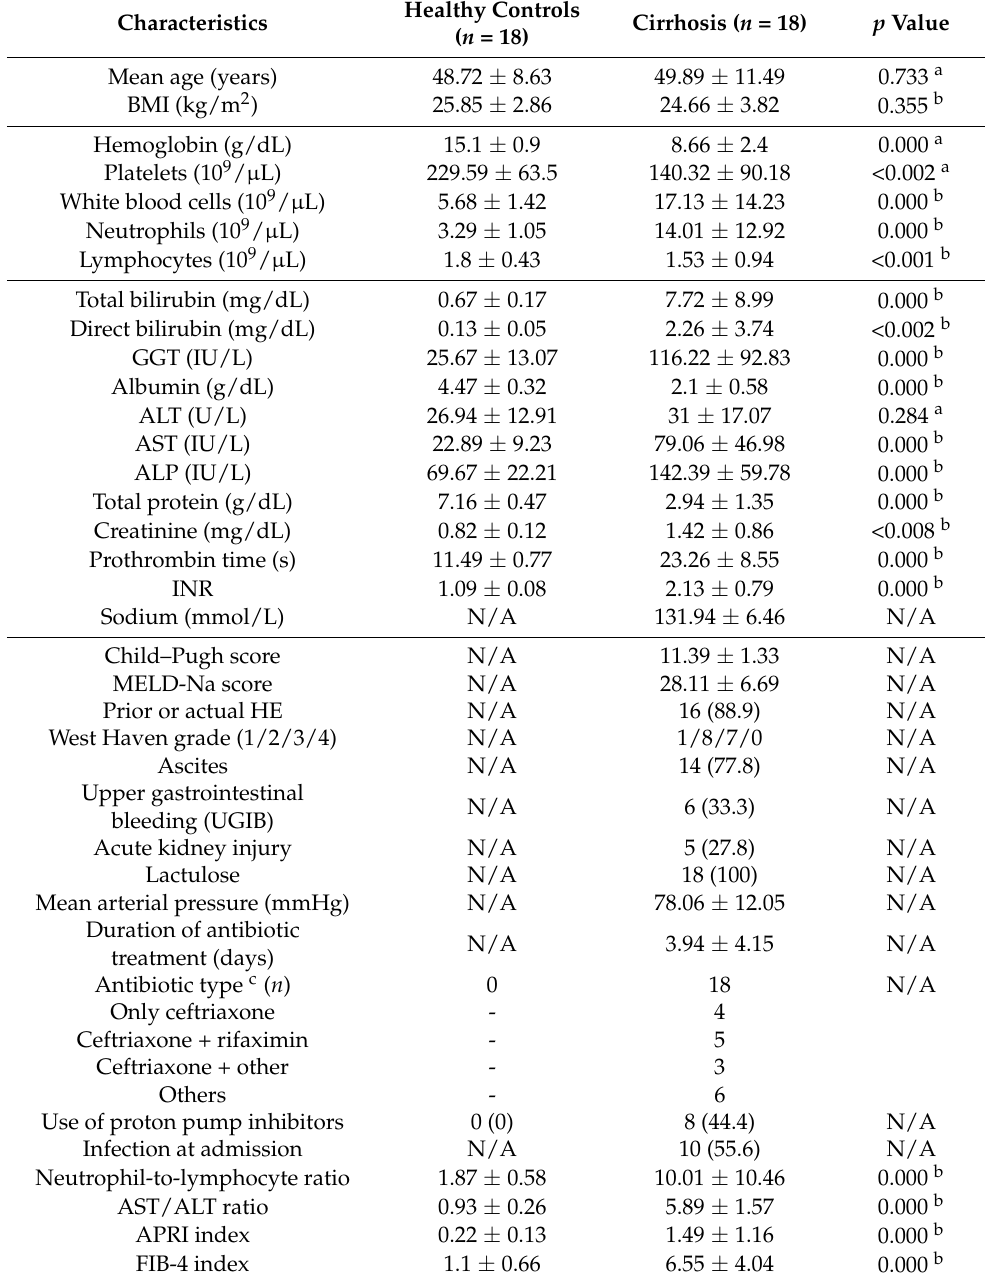
Table 1. Demographic and clinical characteristics of